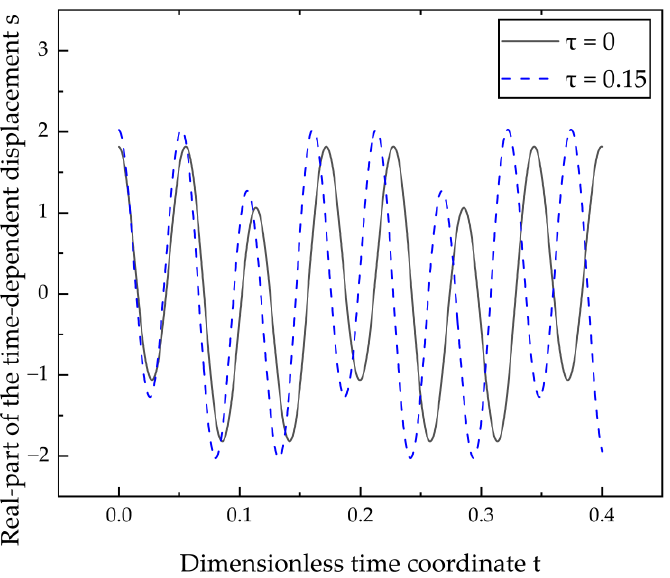
Figure 7. Relations between the time-dependent displacement and the time coordinate.